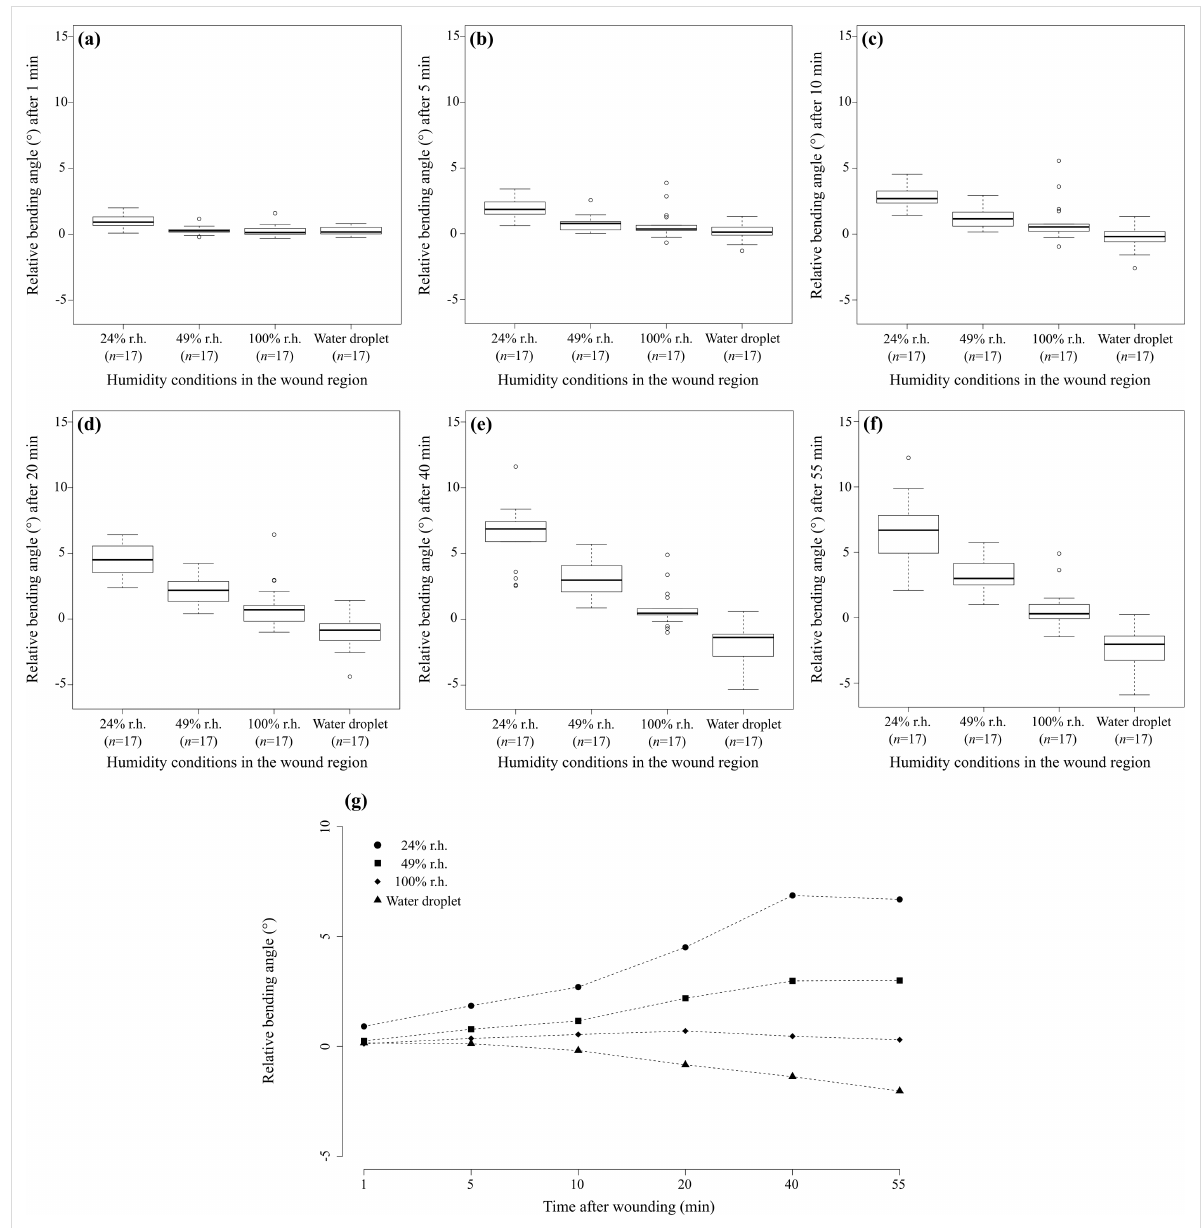
Figure 3: Self-sealing efficiency of Delosperma cooperi leaves. Diagrams show the relative bending angle as a function of “humidity conditions in the wound region” (r.h. = relative air humidity and water droplet) and “time after wounding”. (a–f) Comparative box and whisker diagrams display the rela- tive bending angles γ n dependent on “water” in terms of relative air humidity (r.h.) at 24, 49 and 100% and after a water droplet was applied to a trans- versal wound after (a) 1 min, (b) 5 min, (c) 10 min, (d) 20 min, (e) 40 min and (f) 55 min. (g) For better traceability the significant interaction effect of “humidity conditions in the wound region” and “time after wounding” is presented as the median of measured data (note that the statistical analysis was carried out on rank-transformed data showing the same results).